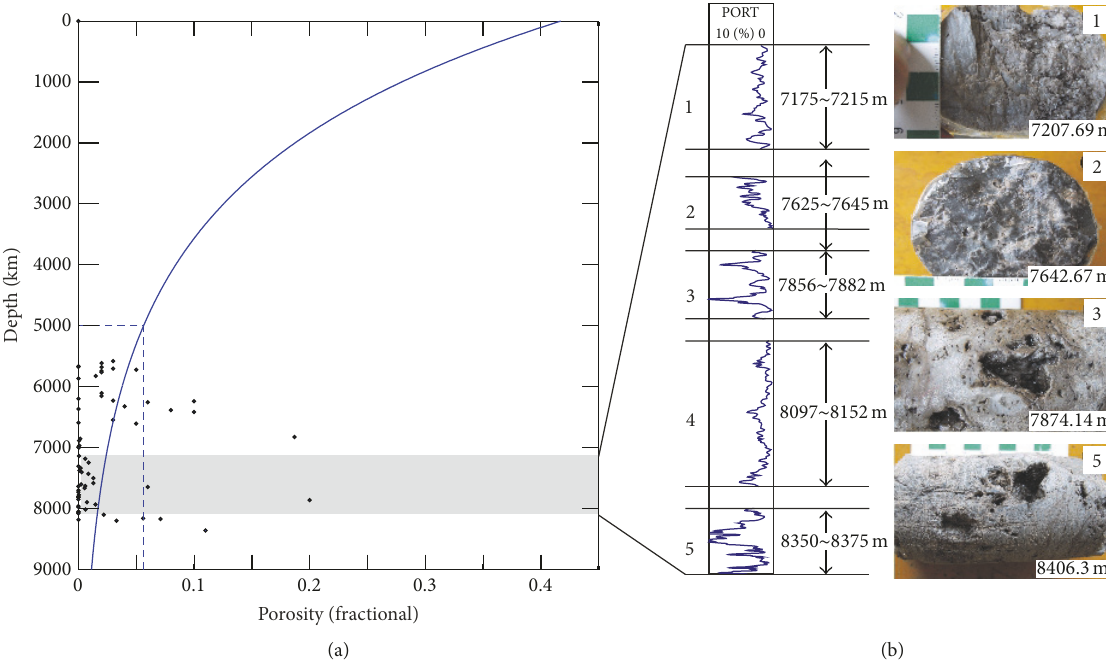
Figure 8: (a) Plot of porosity derived from well logging interpretation against depth in well TS1. The solid line shows the porosity-depth relationship of carbonates according to Schmoker and Halley (1982). The dashed rectangle shows the porosity ranges of carbonates buried below depth of 5000 m. (b) Porosity variations interpreted from well logging in intervals 1–5 with core photos. Note prevalence of dissolved, less-cemented open vugs present in the deeper part of the well.